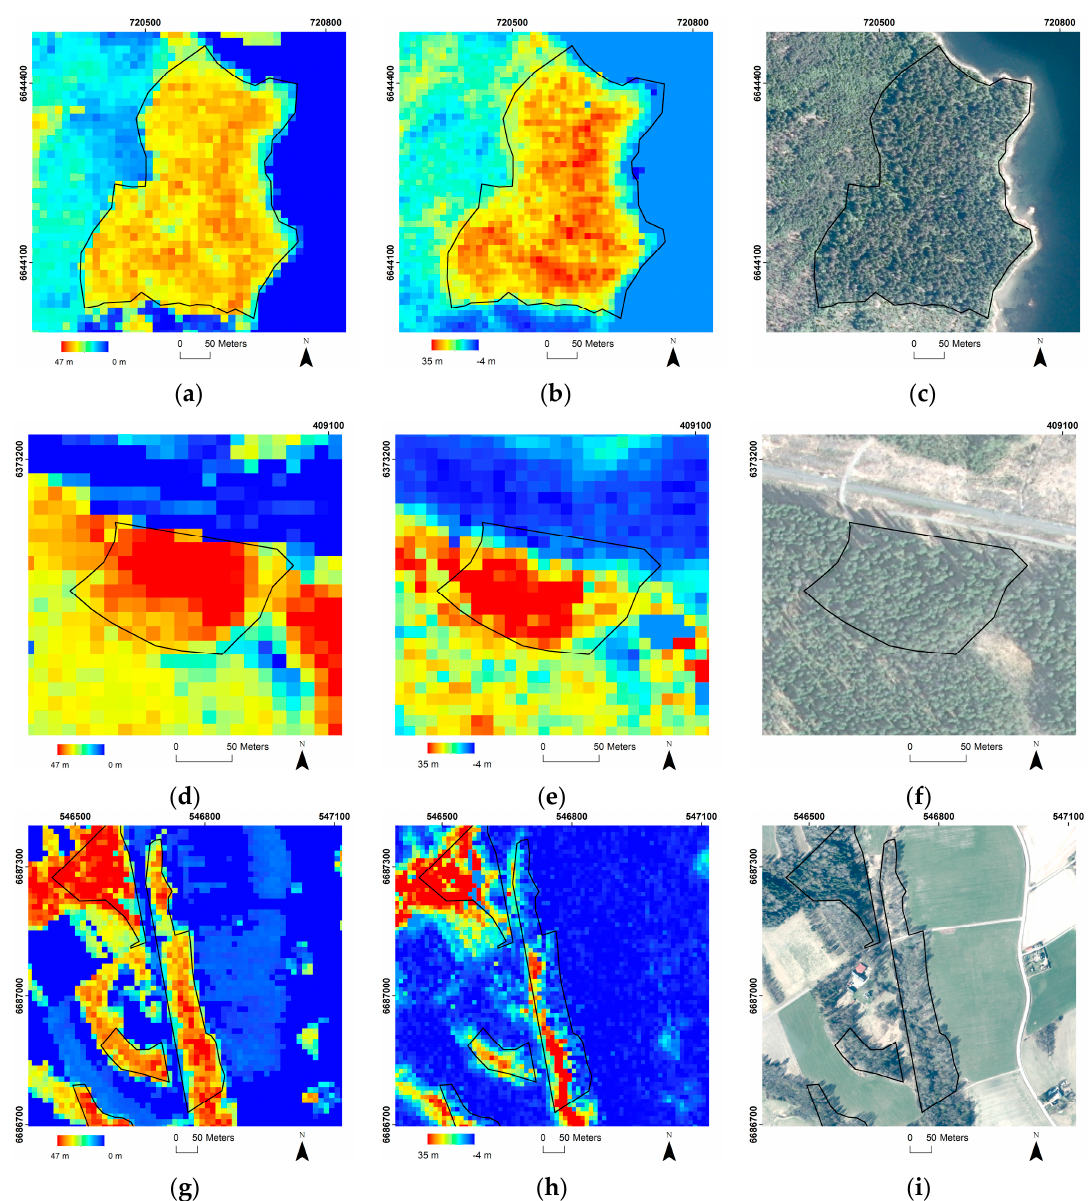
Figure 7. Examples on the geolocation accuracy. First column ( a , d , g ), Lorey’s height estimated from ALS data; second column ( b , e , h ), TanDEM-X phase heights; and third column ( c , f , i ), ortho photographs from Lantmäteriet © .